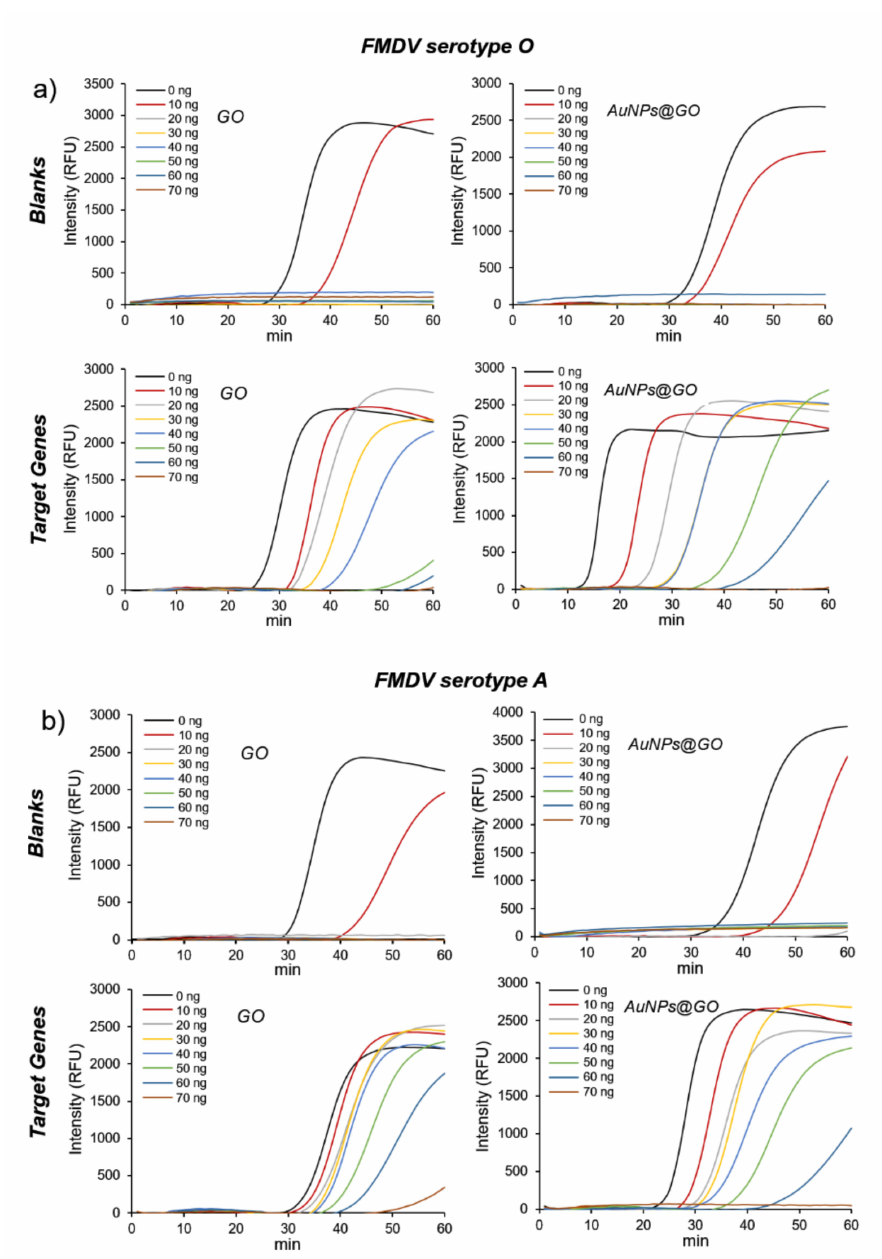
Figure 2. Effect of graphene oxide (GO) and GO–AuNPs (AuNPs@GO) nanocomposite on loop- mediated isothermal amplification (LAMP) reaction using foot-and-mouth disease virus (FMDV) genes. Real-time fluorescence measurement of LAMP reaction for blanks (top) and target genes (bottom) using ( a ) FMDV serotype O and ( b ) FMDV serotype A genes. Left and right panels, GO and AuNPs@GO nanocomposite,